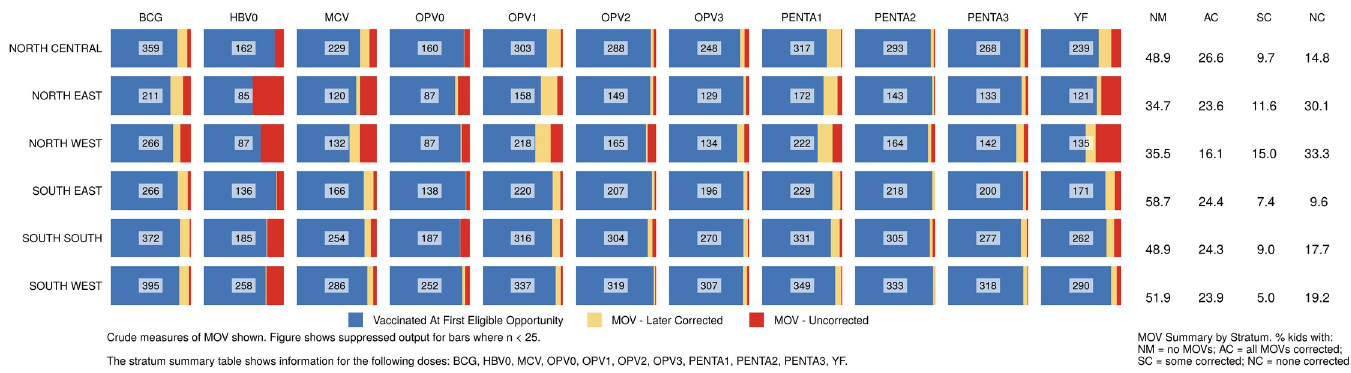
Fig 8. Percentage of children vaccinated at the first eligible opportunity, and percent who experienced one or more missed opportunities, whether later corrected or not. The numbers in the centre of each cell portray the number of children in that zone (row) who had 1+ vaccination visits when age eligible to receive that dose (column). Nigeria MICS/NICS 2016–17.